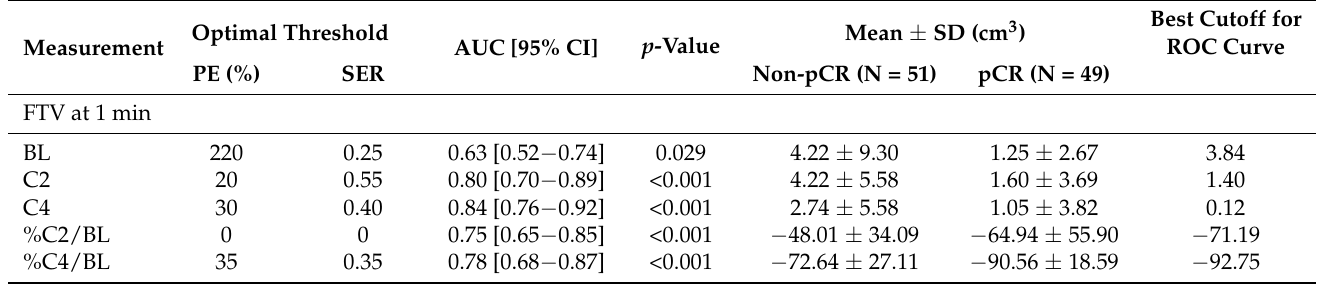
Table 3. Functional tumor volume (FTV) measurements by neoadjuvant systemic therapy response